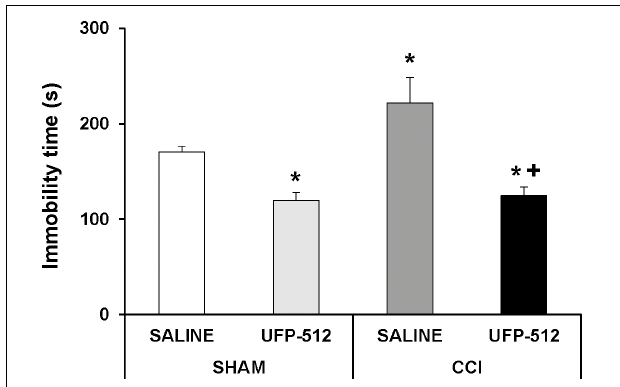
FIGURE 9 | Effects of UFP-512 on the depressive-like behaviors associated with neuropathic pain. Immobility time in seconds (s) for CCI-injured and sham-operated mice treated with 1 mg/kg of UFP-512 or saline evaluated at 28 days after surgery in TST are represented. UFP-512 was administered 1 h before testing. In all groups, ∗ indicates significant differences vs. sham-operated mice treated with saline and + indicates significant differences vs. CCI-injured mice treated with saline ( P < 0.05, one-way ANOVA, followed by the Student–Newman–Keuls test). Results are expressed as mean ± SEM; n = 8 animals for each experimental